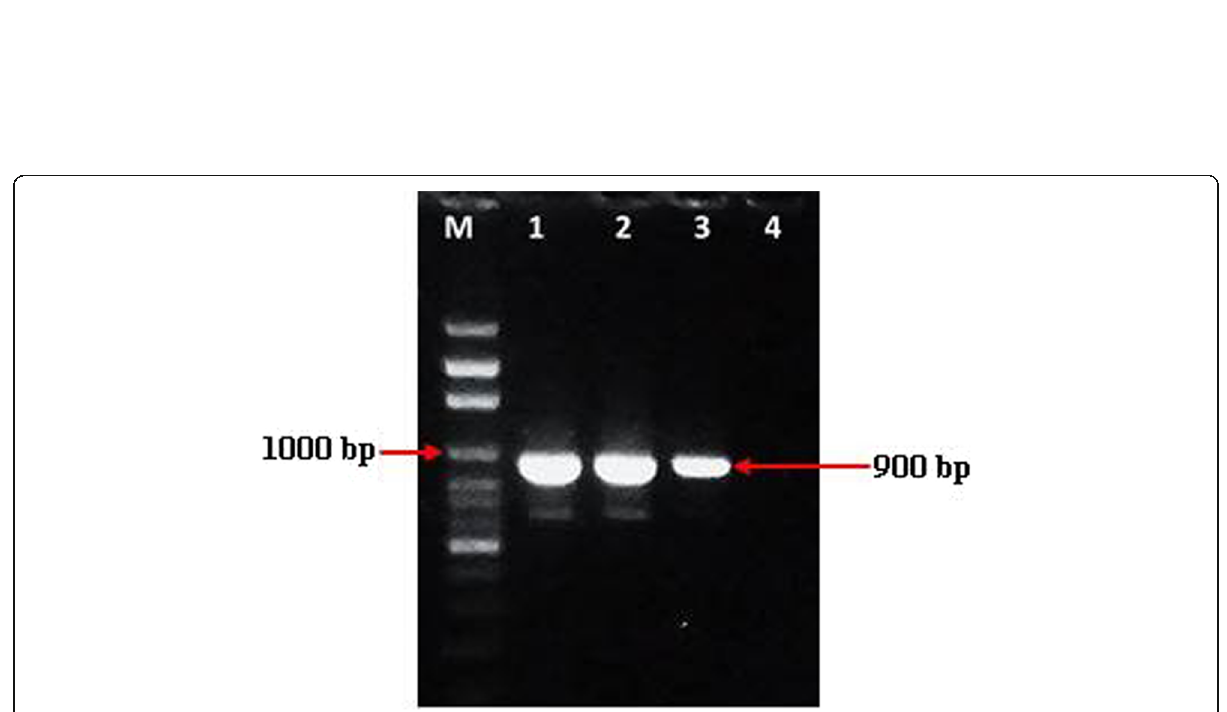
Fig. 7 Agarose gel electrophoresis of polymerase chain reaction of ITS region using ITS4/ITS5 primers. Lanes 1, 2, and 3 are Phyto1, Phyto2, and Phyto3 isolates of Phytophthora nicotianae , respectively. Lane 4 is water, and M is a 100-bp DNA ladder (Solis